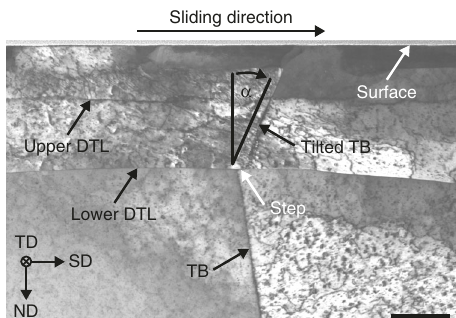
Fig. 1 STEM bright- fi eld (BF) image of tribologically deformed microstructure after a single sliding pass in the vicinity of a twin boundary (TB). Directly above the surface, the fi rst protective platinum layer is visible. The TB as well as the upper and lower dislocation trace lines (DTL) are marked by arrows. Both DTLs extend through the TB to either of its sides. At the intersection of the TB with the lower DTL, a displacement step in sliding direction (SD) is visible. The angle α denotes the inclination between the sample surface normal direction and the TB segments separated by the DTLs. Sliding direction (SD), normal (force) direction (ND) and transverse direction (TD) form the right-handed sample coordinate system indicated in the image and used throughout this work. The scale bar corresponds to 200